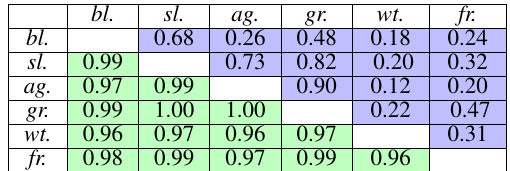
Table 7. Cosine similarities between mean feature vectors of layer f1 for CL-f1 (blue) and Cr-En